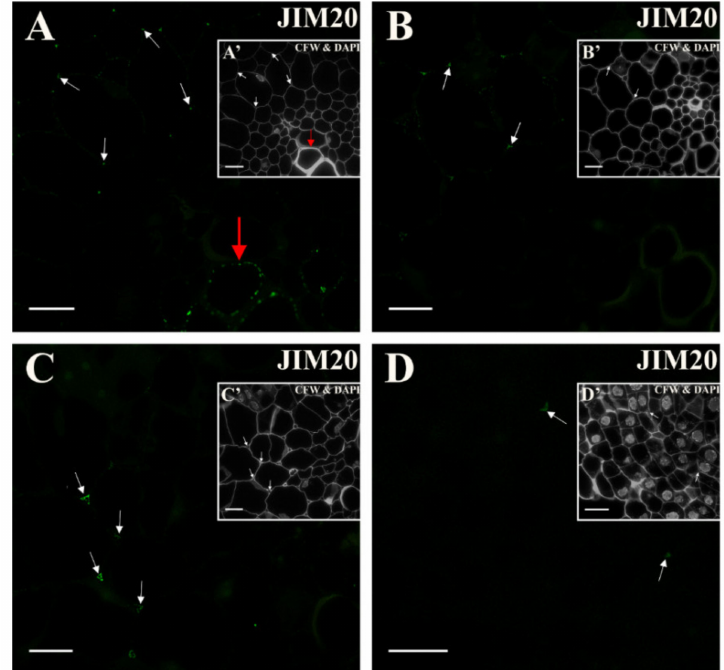
Figure 13. Distribution of the extensin epitope that is detected by the JIM20 antibody in the explant cells ( A ) At the start of the culture signal was detected in the cell corners between the pericycle cells (white arrows) and in the walls of the vessels (red arrow). ( B ) After two days signal was present only in some of the intercellular spaces between the elongated pericycle cells (arrows). ( C ) In the following days signal was detected only in some of the intercellular spaces between the cells that were undergoing their first division (arrows). ( D ) From the 10th day of the culture signal disappeared (arrows). Scale bars: A – D —10 µ